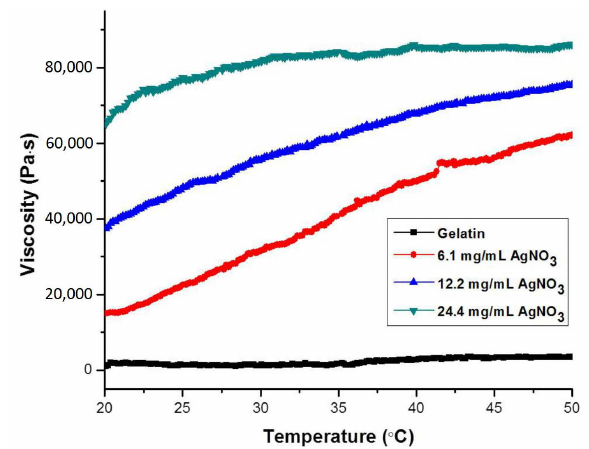
Figure 3. Temperature-dependent viscosities of gelatin solution and DA-GLT 1 /AgNO 3 composite hydrogels at different feeding concentrations of AgNO 3 .